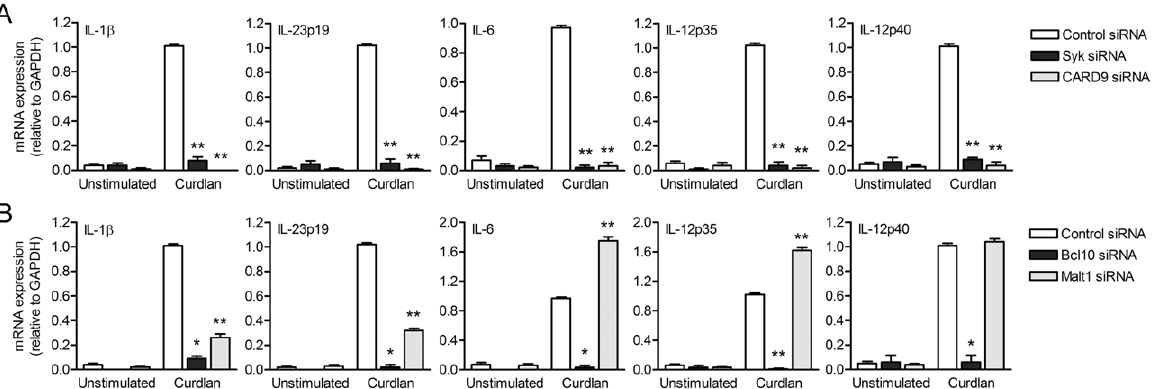
Figure 1. Dectin-1-induced cytokine expression requires Syk, CARD9 and Bcl10, whereas Malt1-mediated signaling enhances IL-1 b and IL-23p19, but decreases IL-6 and IL-12p35 expression. (A and B) Quantitative real-time PCR for indicated mRNAs in curdlan-stimulated DCs after Syk, CARD9 (A), Bcl10 and Malt1 (B) silencing by RNA interference (siRNA). Expression is normalized to GAPDH and set at 1 in curdlan- stimulated cells. Data are mean 6 s.d. of four independent experiments, * p , 0.05 and ** p , 0.01 (Student’s t